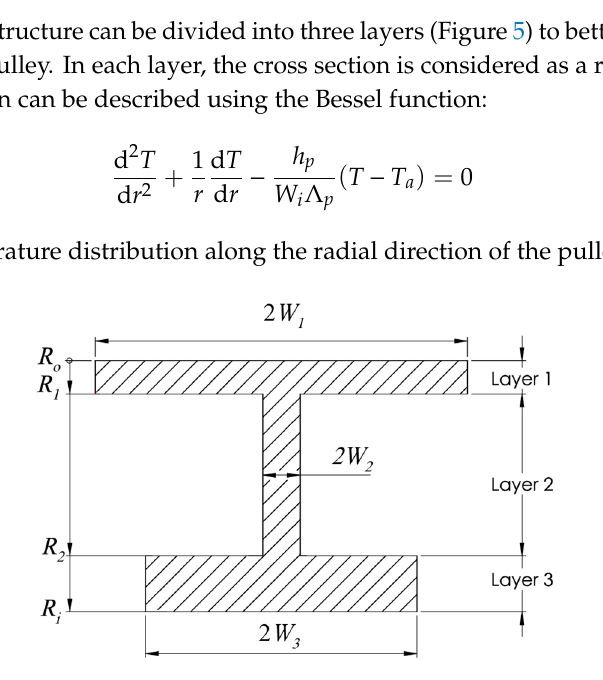
Figure 4. Simplification of the pulley structure.